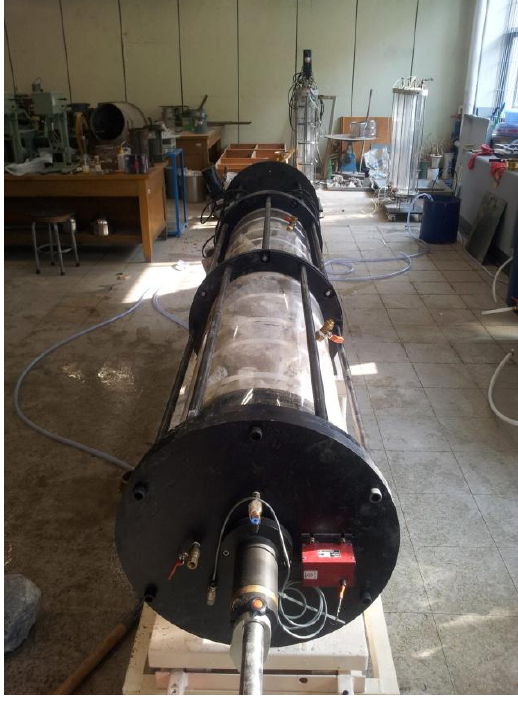
Figure 3. Grouting